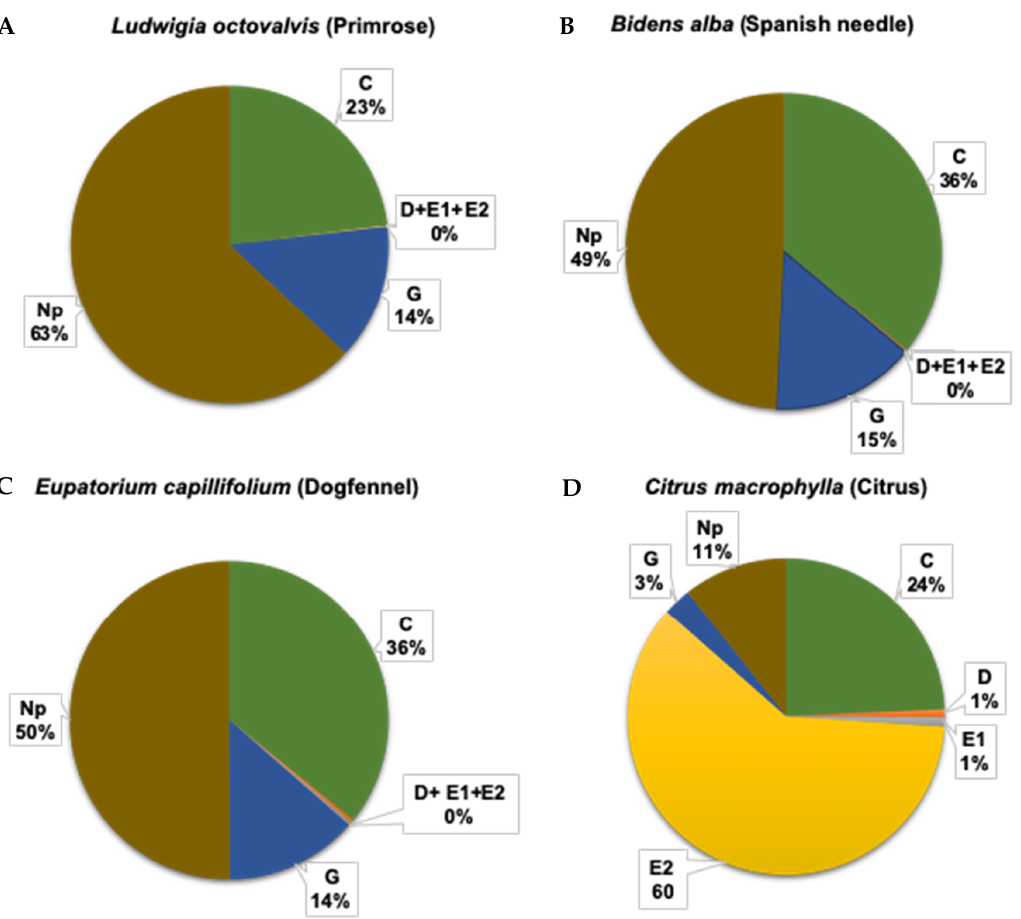
Figure 2. Percent duration of each feeding activity (C, D, E1, E2, G, and Np) performed by Diaphorina citri nymphs on various weed species and citrus during 18 h EPG recordings. ( A ) Primrose, n = 18; ( B ) Spanish needle, n = 22; ( C ) Dogfennel, n = 18; and, ( D ) Citrus macrophylla , n = 22.